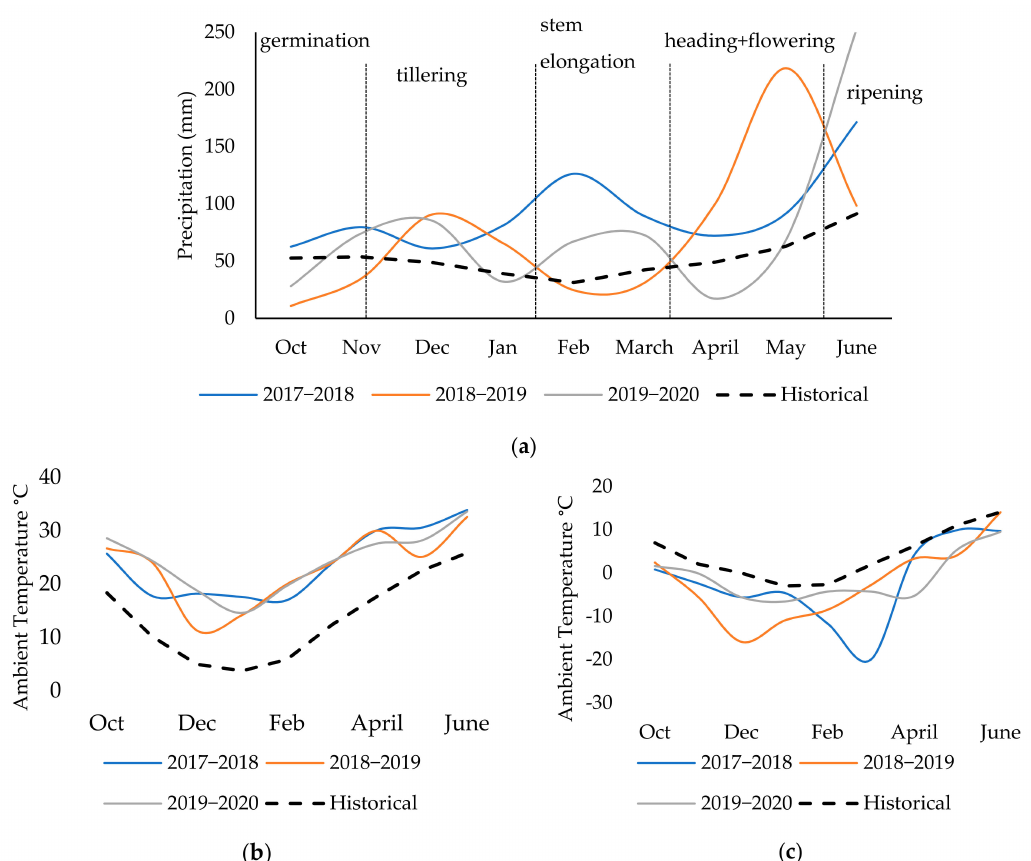
Figure 1. Climate data and weather; precipitation ( a ), average temperature ( b ), and minimal temperatures ( c ) in Ravno Selo, during 2018–2020 growing seasons (site-years 1, 3, and 4).